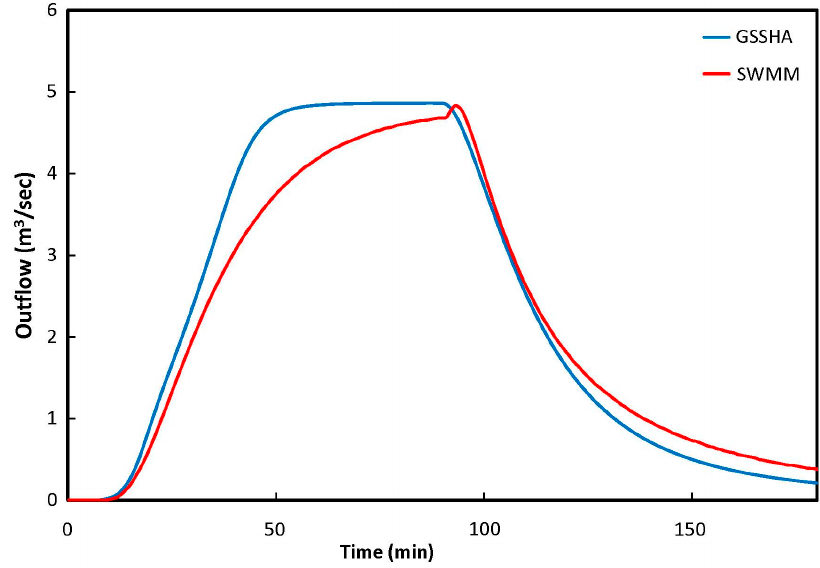
Figure 6. Tilted V-Catchment outflow hydrographs.